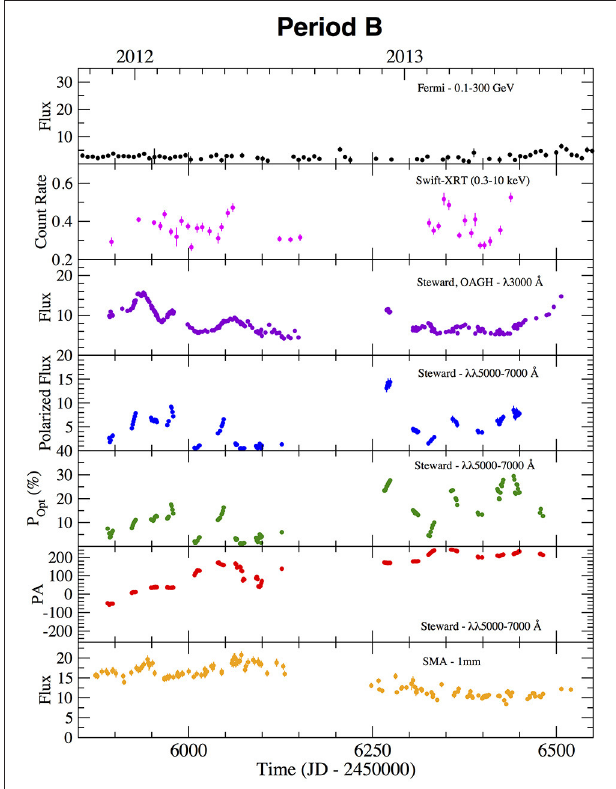
FIGURE 2 | Light Curves for 3C 279 during period B. Units are the same as in Figure 1 .